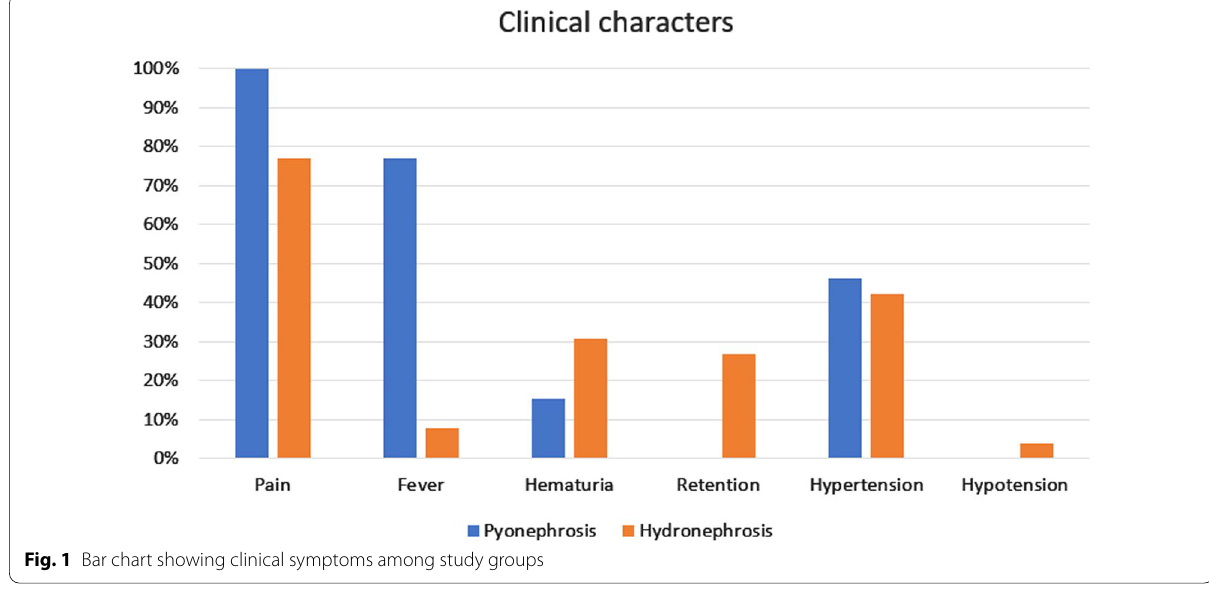
Fig. 1 Bar chart showing clinical symptoms among study groups